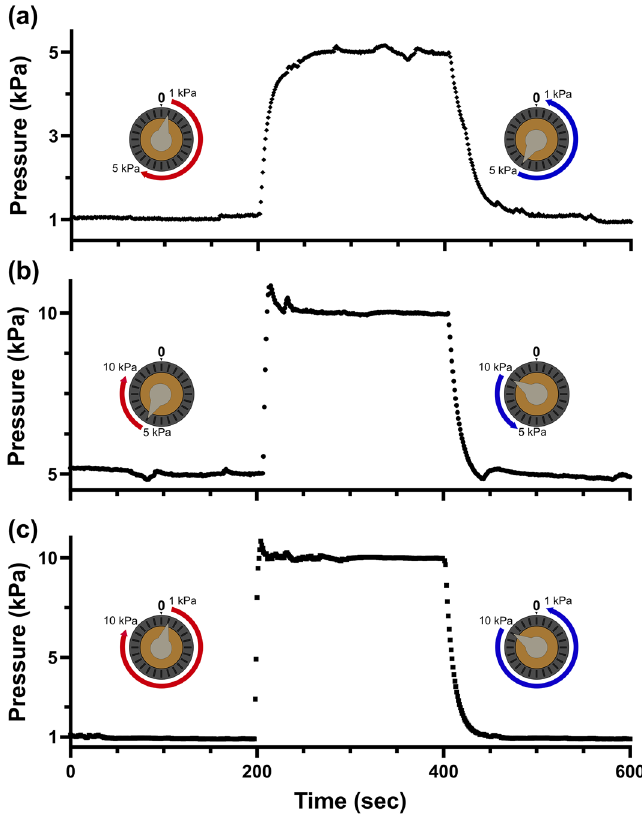
Figure 7. Dynamic responses of pressure patterns including, ( a ) 1 to 5 to 1 kPa, ( b ) 5 to 10 to 5 kPa, and ( c ) 1 to 10 to 1 kPa are achieved via control knob turns with the calibration data in Fig. 4a. Each pattern features three stages, each with 200 s under the real-time observation of the dynamic pressure response.